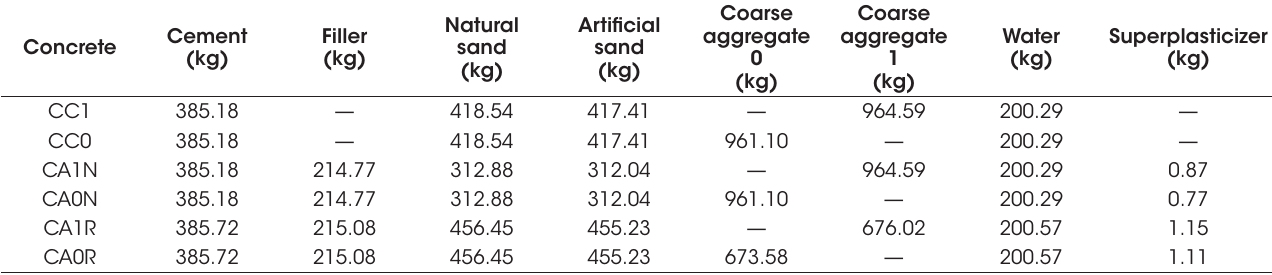
Mixture proportions for CC and CA mixtures (kg/m³)